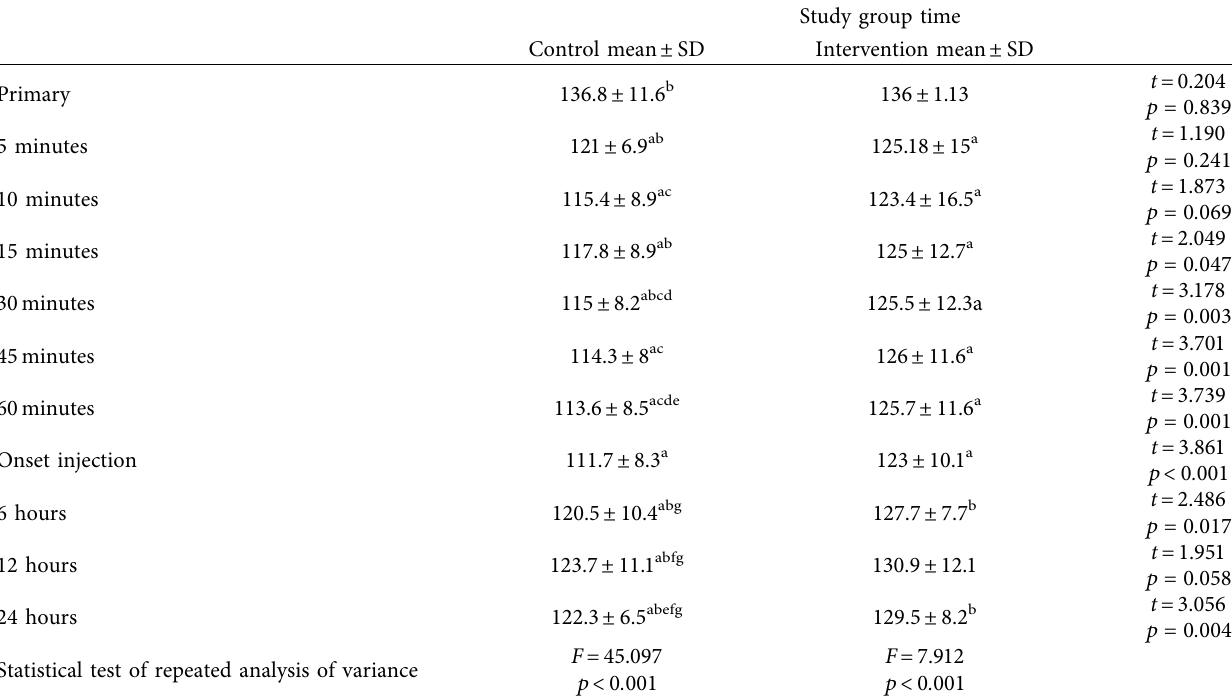
Table 3: Comparison of mean systolic blood pressure of two groups at diferent times.